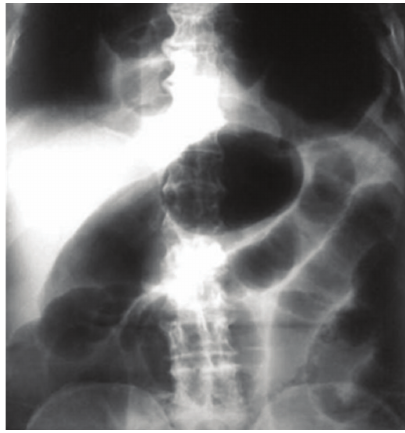
Figure 1: Preoperative chest roentgenogram showing a large hiatal hernia.